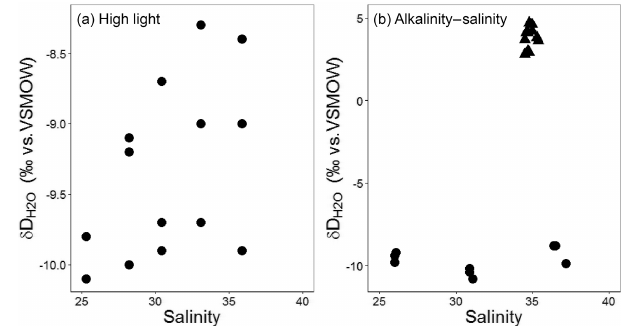
Figure 1. The figure shows the lack of correlation between δ D H 2 O and salinity of the culture media for both the high-light (a) and the alkalinity–salinity (b) experiments. The triangles in the alkalinity– salinity plot are the δ D H values of the media covering a range of 2 O alkalinity, whereas the circles represent the δ D H values for the 2 O constant alkalinity media.